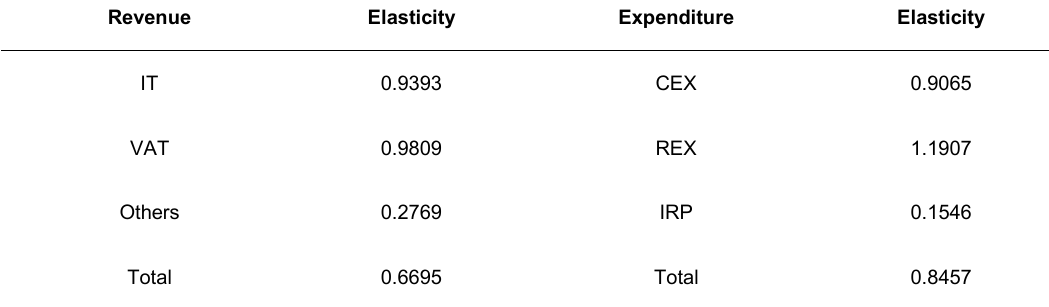
Table 3. Potential Output Elasticity.